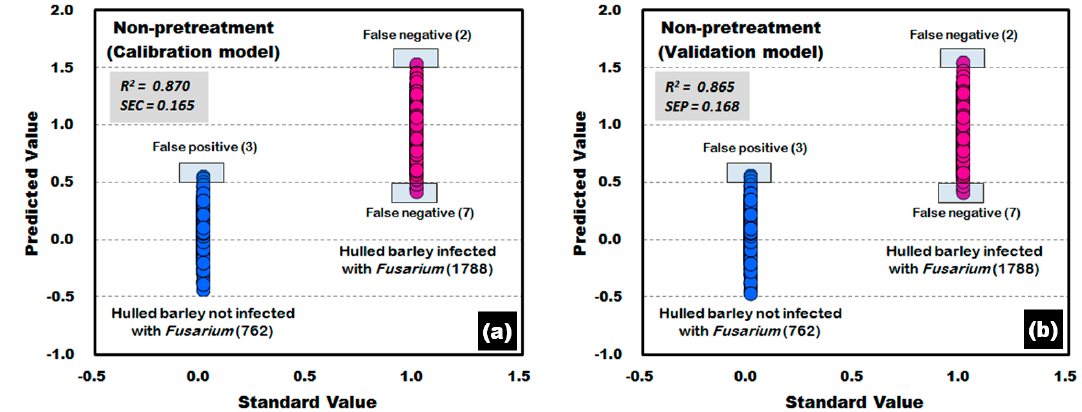
Figure 11. Fusarium discrimination calibration ( a ) and validation ( b ) results of the PLS-DA model developed using raw reflectance spectra obtained from the front side and back side of the hulled barley.